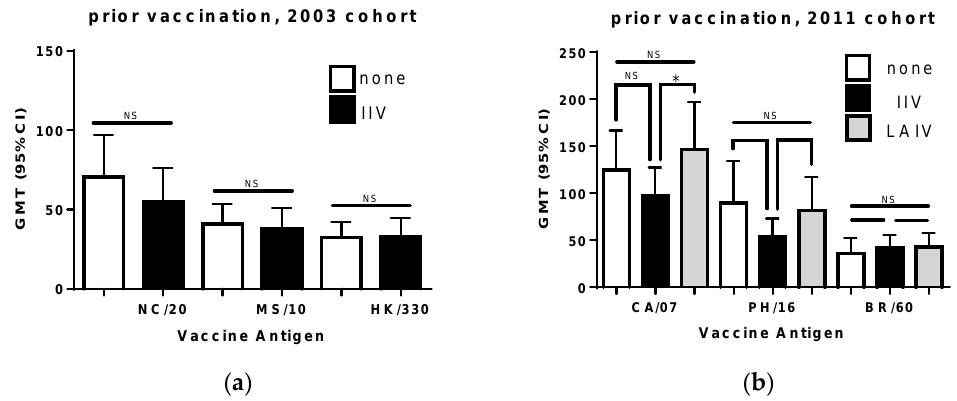
Figure 2. The geometric mean titers (with 95% confidence interval) for previously unvaccinated subjects are compared to titers of those with records of vaccination the previous season. Results are shown for the ( a ) 2003 and ( b ) 2011 cohorts. The viruses used for testing HI titer are listed on the x axis: NC/20, A/New Caledonia/20/1999 (H1N1); MS/10, A/Moscow/10/1999 (H3N2); HK/330, B/Hong Kong/330/2001 (Victoria lineage); CA/7, A/California/07/2009 (pdmH1N1); PH/16, A/Perth/16/2009 (H3N2); and BR/60, B/Brisbane/60/2008 (Victoria lineage). The difference between the previously vaccinated group and those vaccinated in the current season was evaluated using the Mann Whitney rank test. n.s., not significant; and *, p <